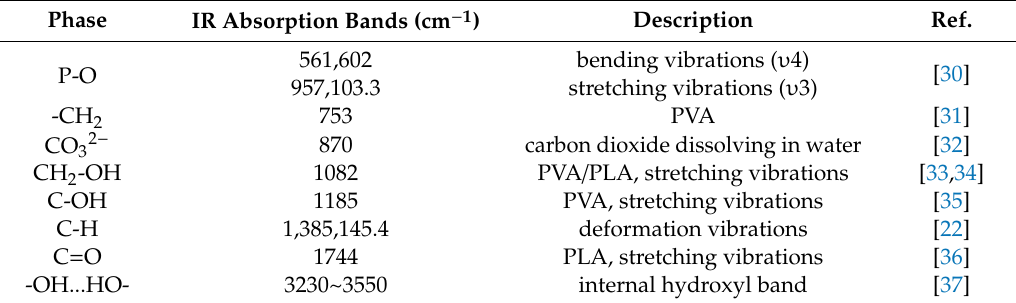
Figure 6. FTIR spectrum of HA coating on PVA/PLA braids at different deposition time. Table 1. Assignment of FTIR spectra of PVA/PLA-HA braid presented in Figure 6.